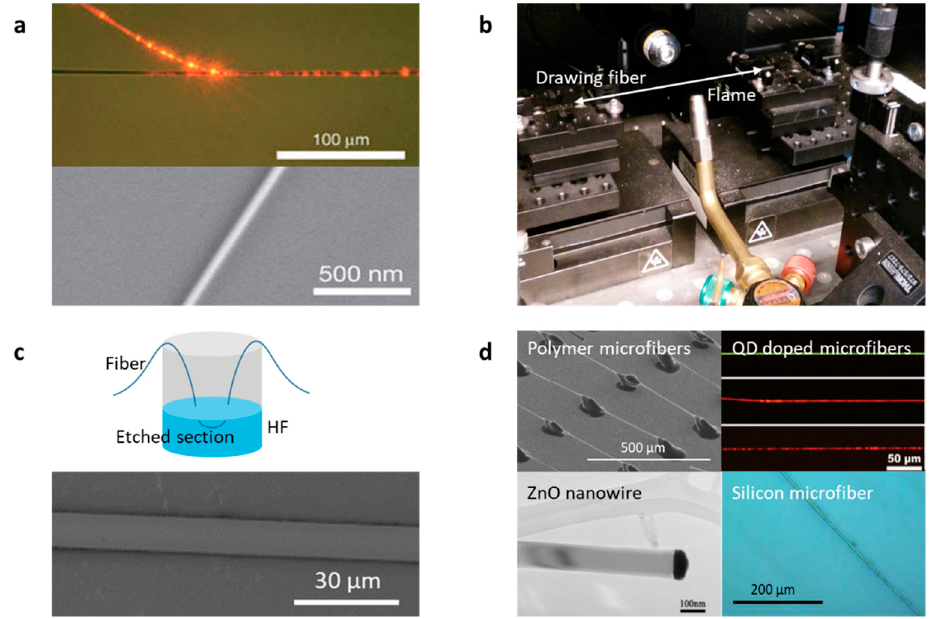
Figure 4. Fabrication of microfibers. ( a ) Pictures of silica microfibers. ( b , c ) Setups for fusing & drawing glass microfibers. ( d ) Microfibers besides glass materials. Here pictures of ( a , d ) are reproduced from Ref. [1] and Refs. [62–66], respectively.